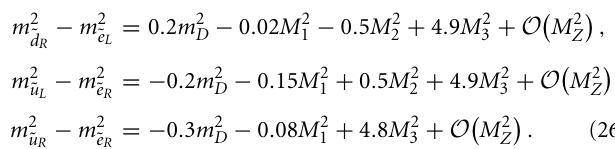
(a) universal gauginos (solid), (b) light bino case (short